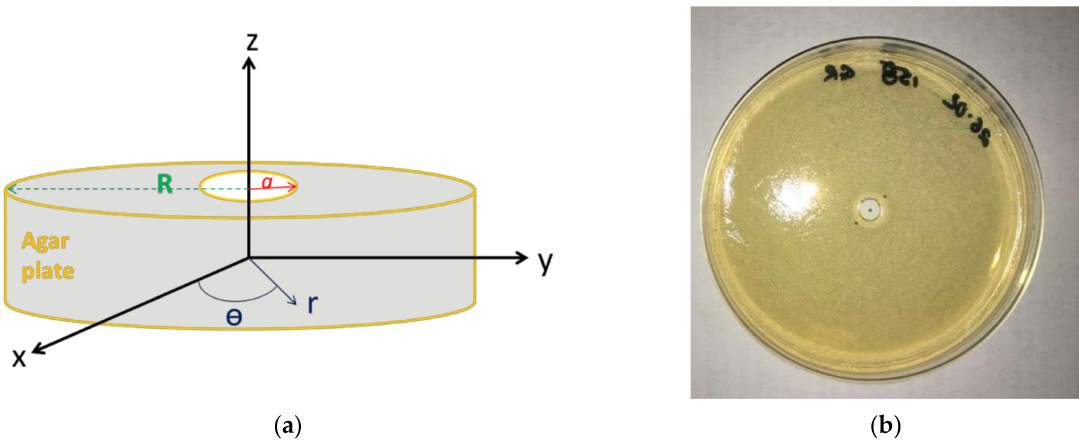
Figure 1. Agar plate with a well in the center: ( a ) scheme and ( b ) top view of the